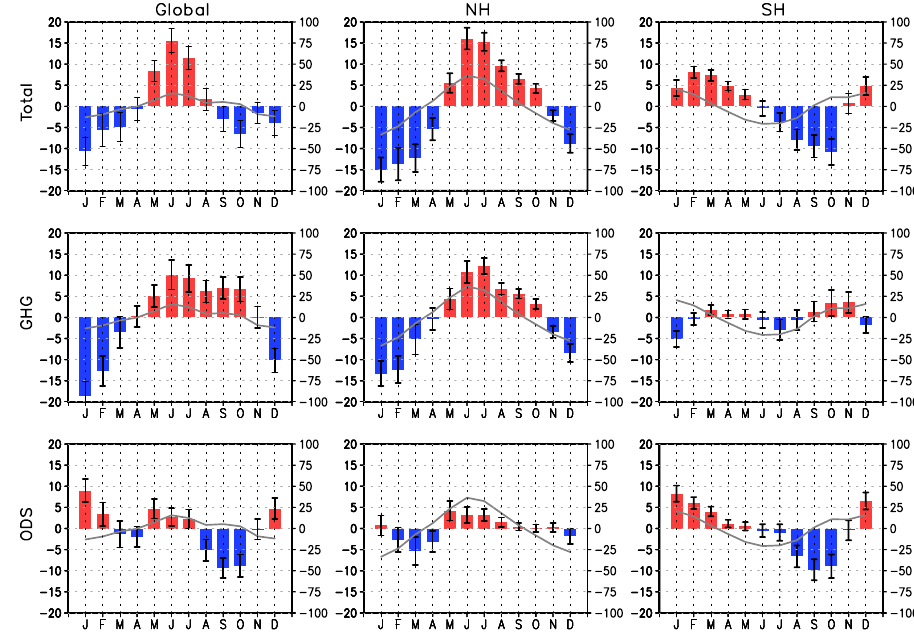
Figure 7. Same as Fig. 5 but for the change in seasonal breathing ( − d M/ d t ) [Tgmonth − 1 ]. The absolute value for − d M/ d t of the reference simulation REF2000 is shown as a grey line with the corresponding y axis on the